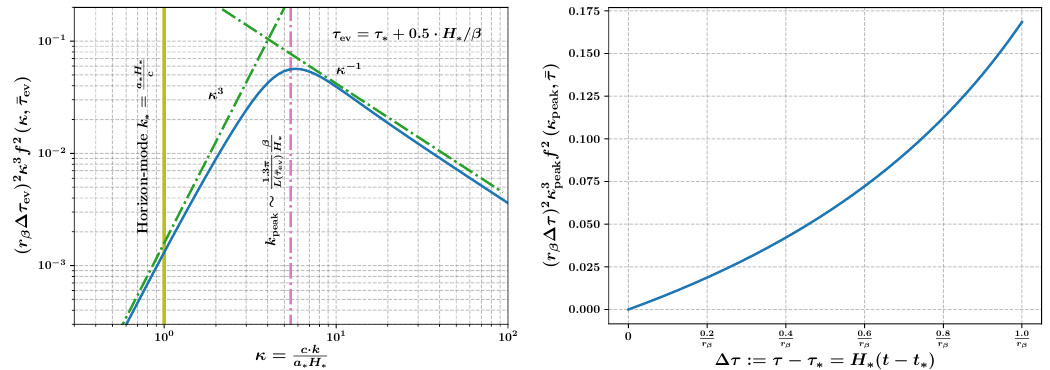
Figure 2: Left: The dimensionless power spectrum (with approximated time inte- gral) of GWs sourced by a FPT evaluated at halftime τ = τ ∗ + 0.5 · H ∗ /β . Right: The time evolution of the peak of the dimensionless power spectrum. The inverse duration in terms of Hubble time is denoted by r β = − τ mean while ∆ τ : = τ ∗ ev ev